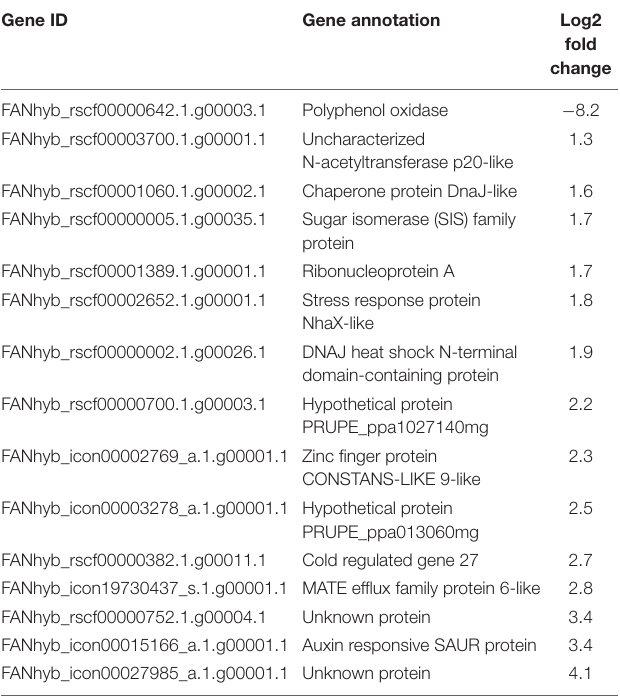
TABLE 1 | Upregulated and downregulated genes (RNA sequencing) by the addition of biochar and Botrytis cinerea infection on the leaves. Gene ID Gene annotation Log2